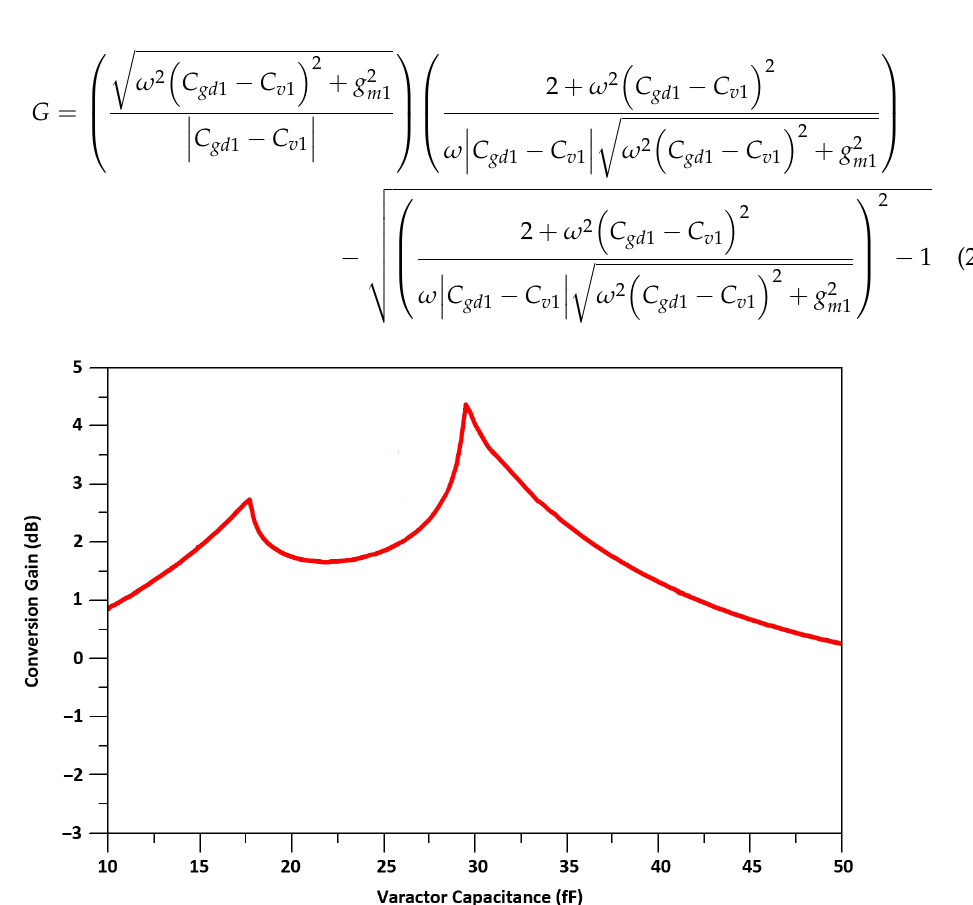
Figure 11. Theoretical result of G.